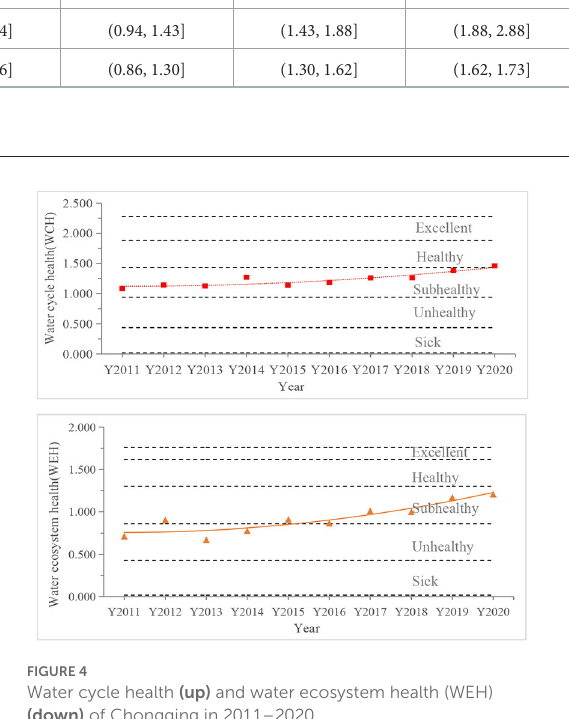
supply pervasion in urban (P4), the green rate of built-up